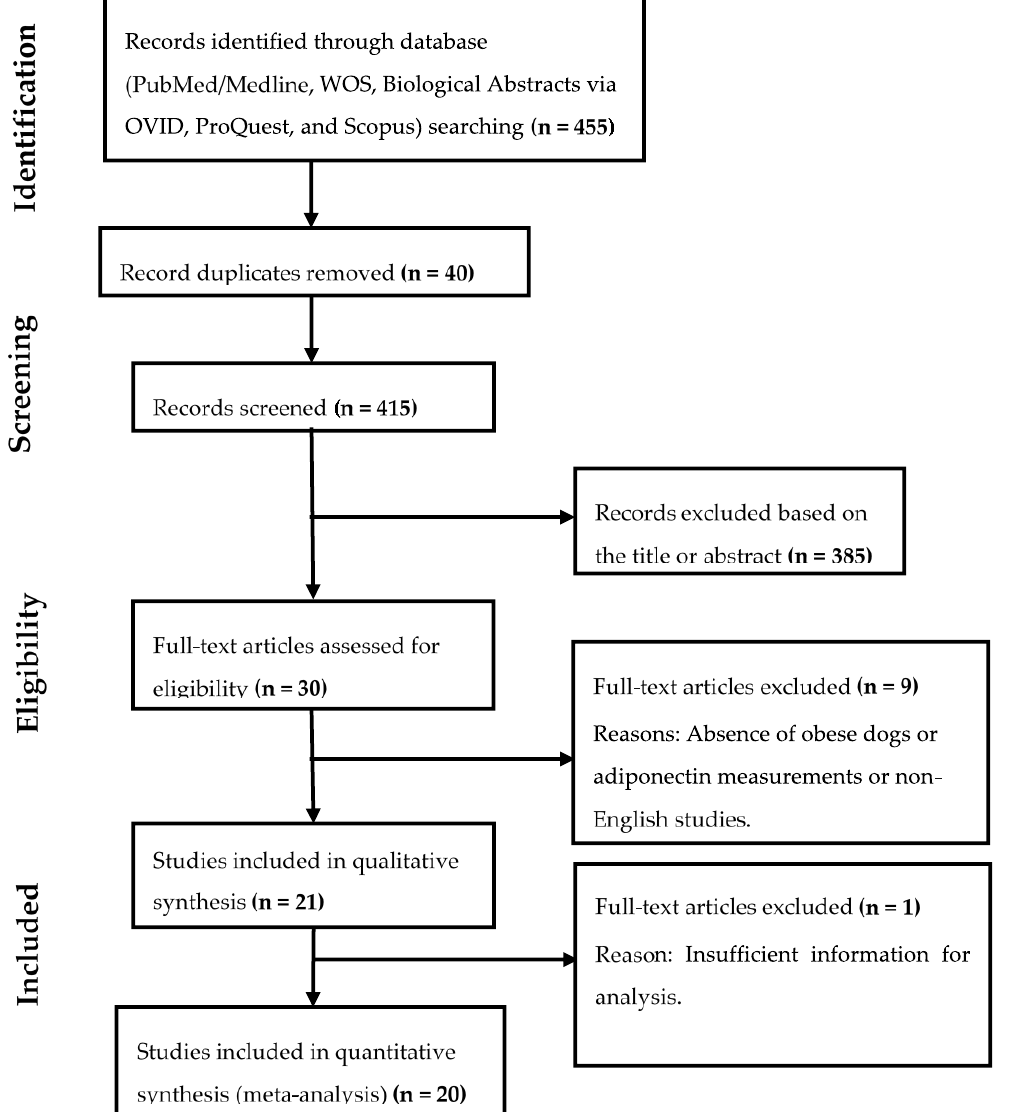
Figure 1. Flow diagram of literature selection for the meta-analysis. WOS: Web of Science.